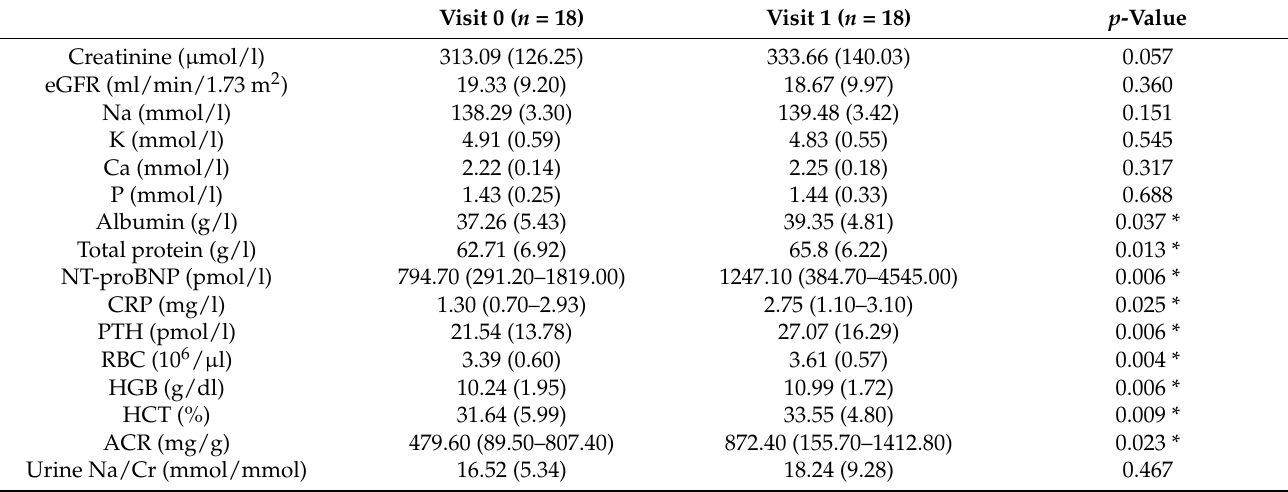
Table 2. Serum biochemical and complete blood count parameters and urine biochemical parameters